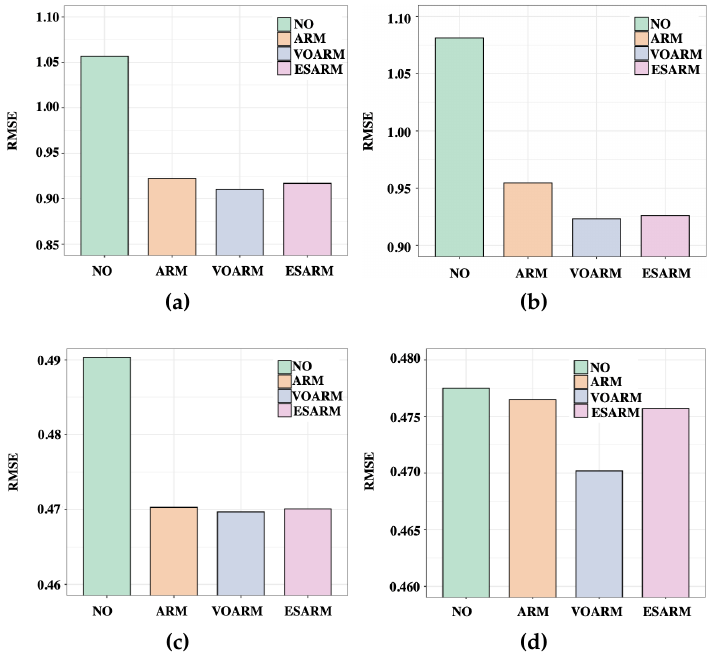
Figure 6. Performance in item-rating prediction under different settings, using different pre-training methods. ( a ) MF, RealSet-explicit. ( b ) NCF, RealSet-explicit. ( c ) MF, RealSet-implicit. ( d ) NCF,